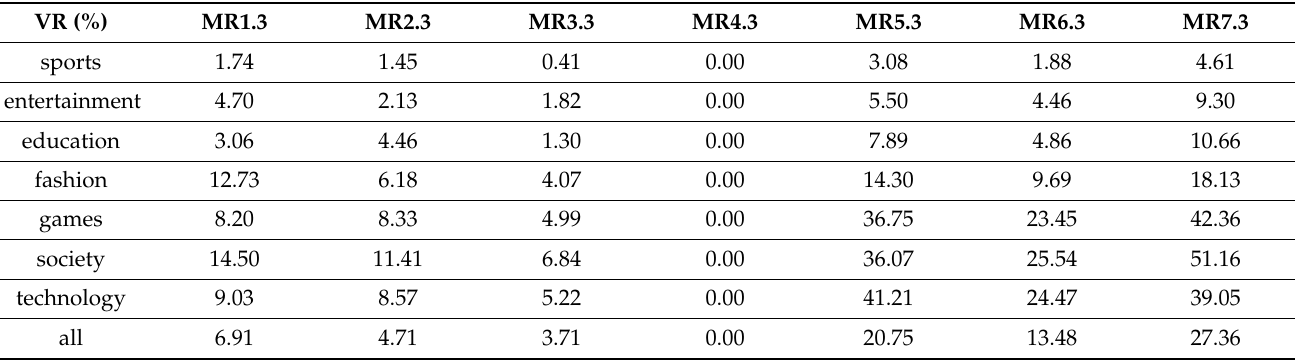
Table 11. TencentNLP text classification